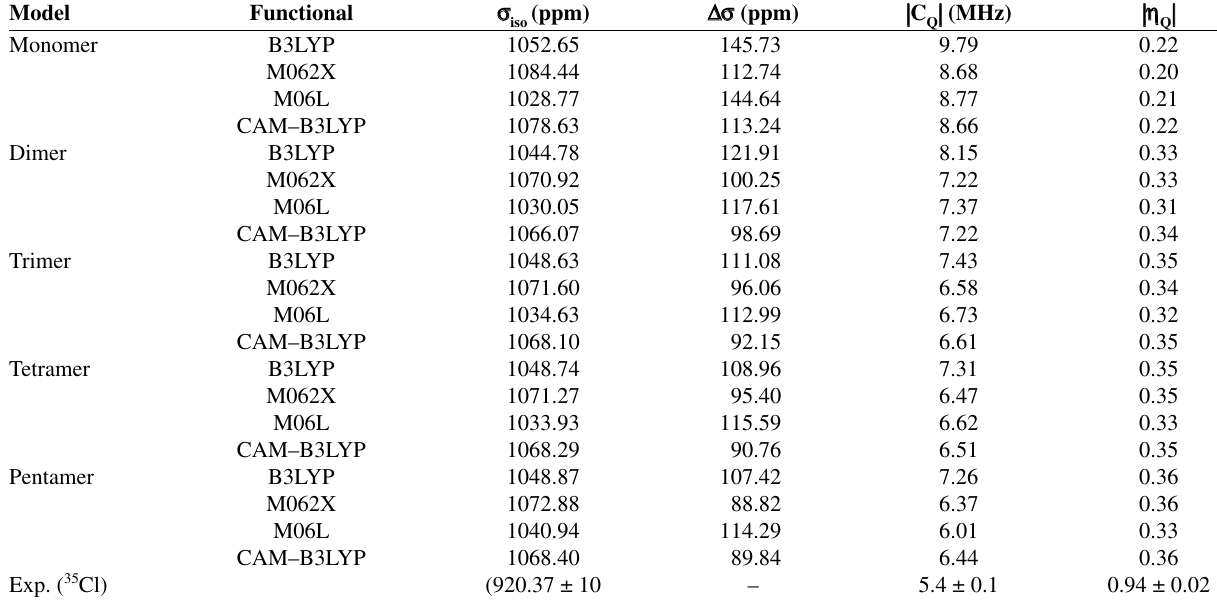
Table 3. Calculated chlorine-35 quadrupolar and chemical shift data for various threonine hydrochloride clusters. Model